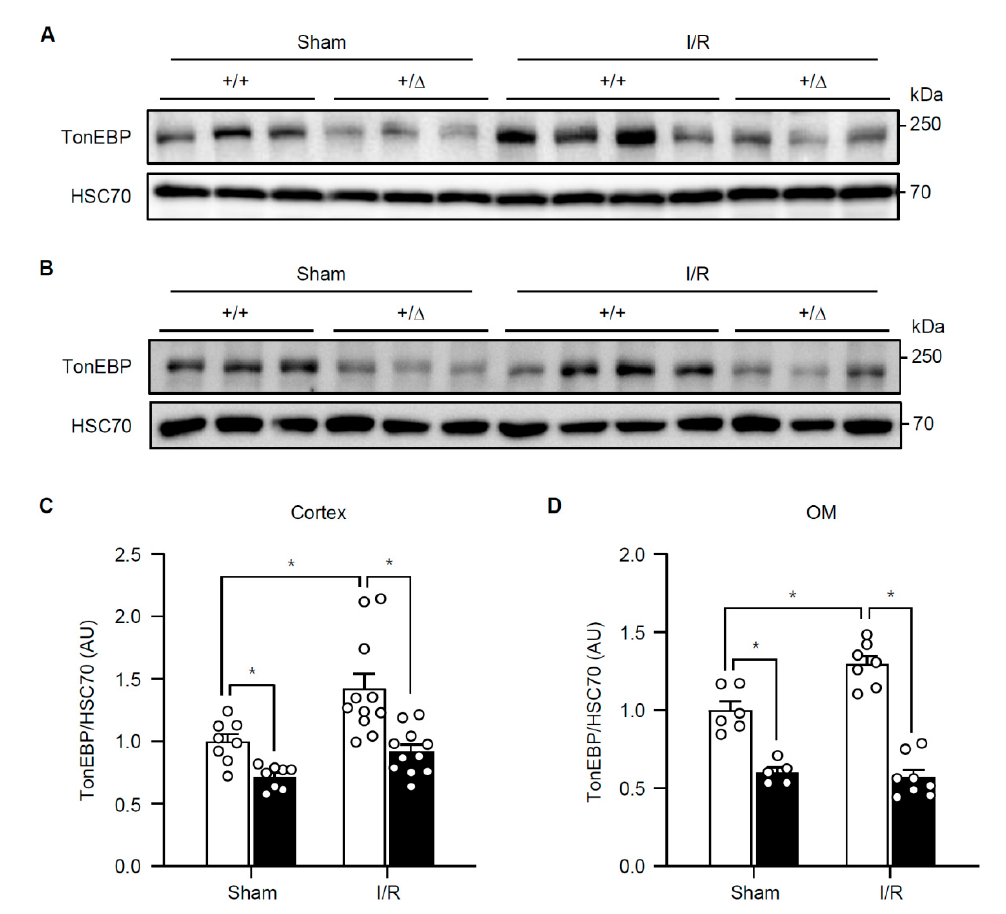
Figure 1. TonEBP (tonicity-responsive enhancer binding protein) expression in TonEBP +/ ∆ ( +/ ∆ , filled bars) mice and their TonEBP +/+ littermates ( +/+ , open bars) after ischemia / reperfusion (I / R) or sham treatment of kidneys. TonEBP and Hsc70 immunoblot were performed from renal cortices ( A ) and renal outer medullae (OM) ( B ), ( C , D ) Ratio of TonEBP and Hsc70 band intensity was determined and shown in arbitrary unit (AU). Mean + SEM, * p < 0.05.